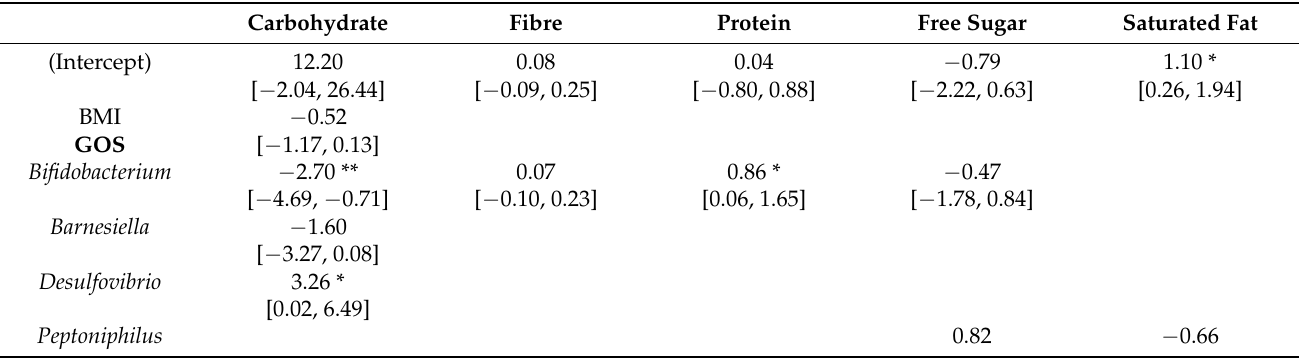
Table 3. Stepwise regression results for each nutrient